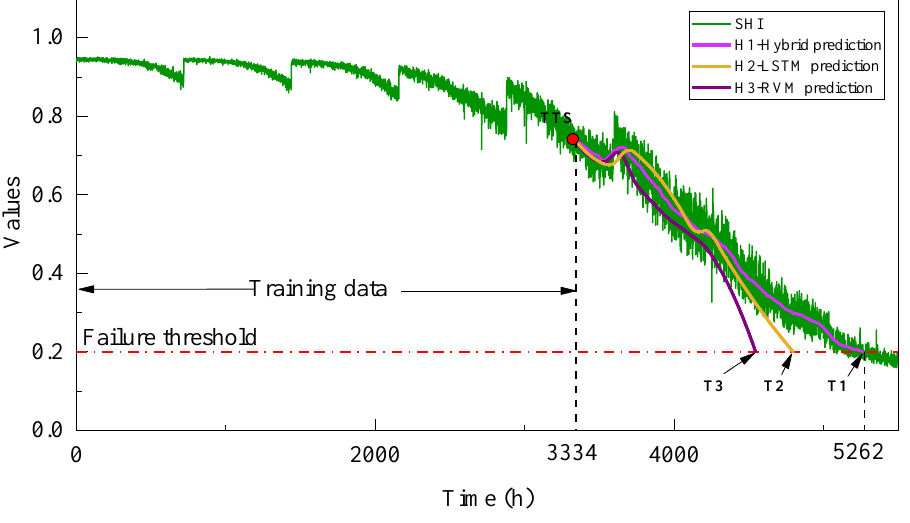
Figure 12. Prediction effect of different methods.